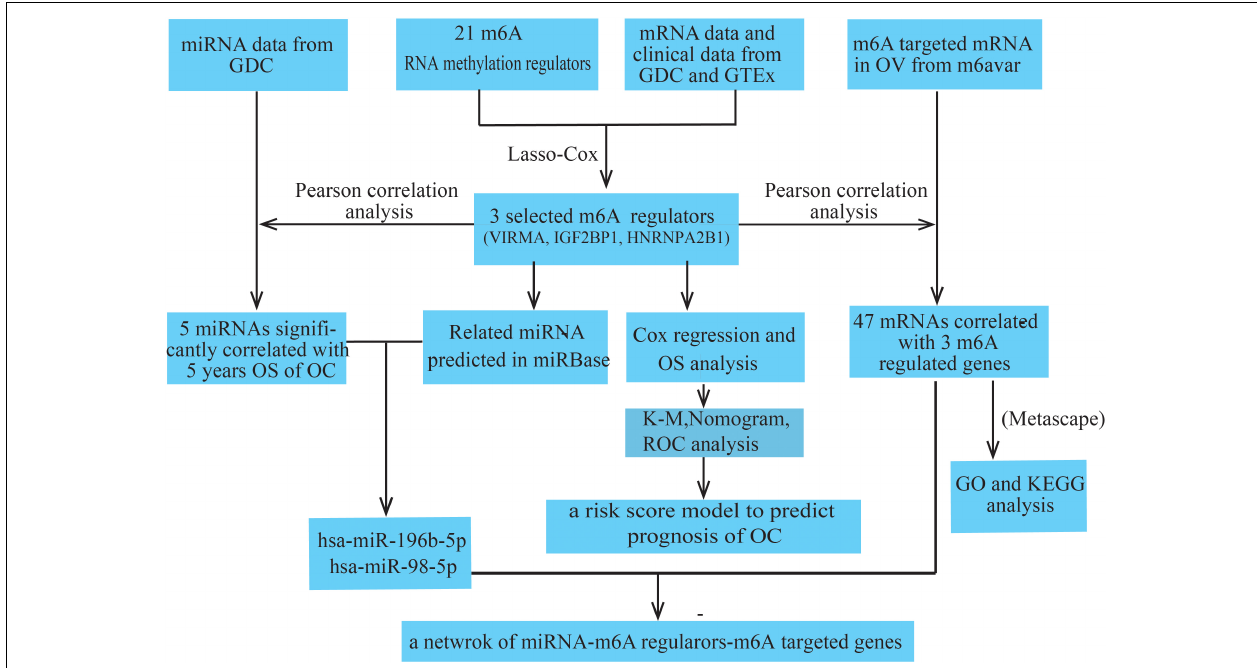
FIGURE 1 | Workflow and analysis strategy used in the current